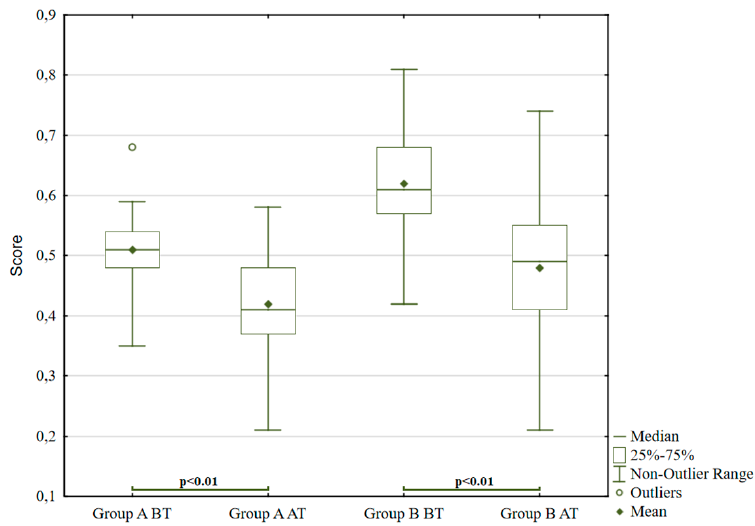
Figure 5. The Hand Test for non-adaptive behaviour.